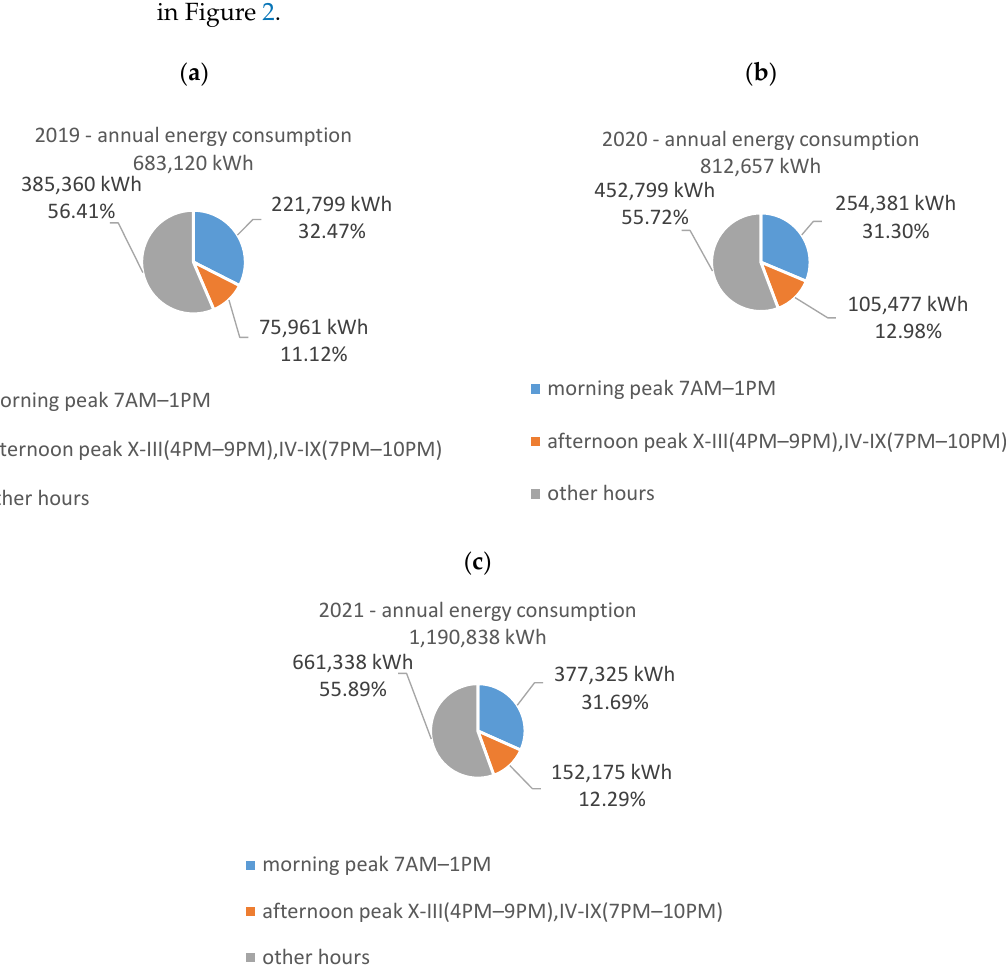
Figure 2. Annual energy consumption of the investigated factory in years: ( a ) 2019, ( b ) 2020, ( c )